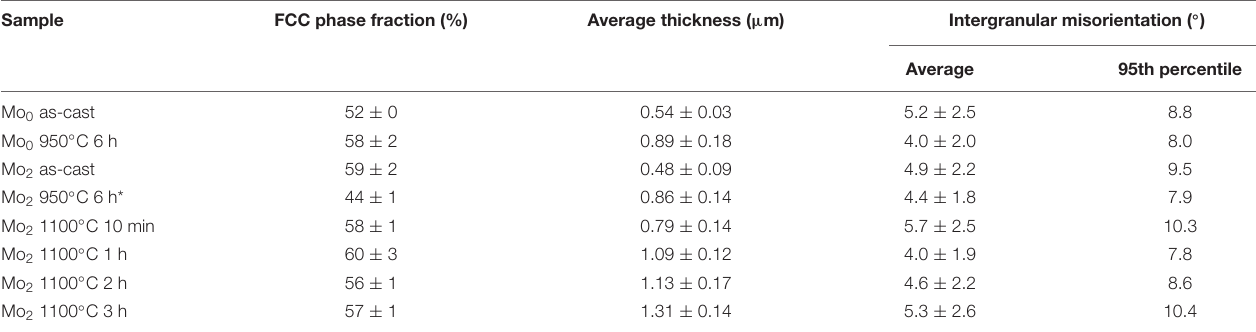
Average 95th percentile